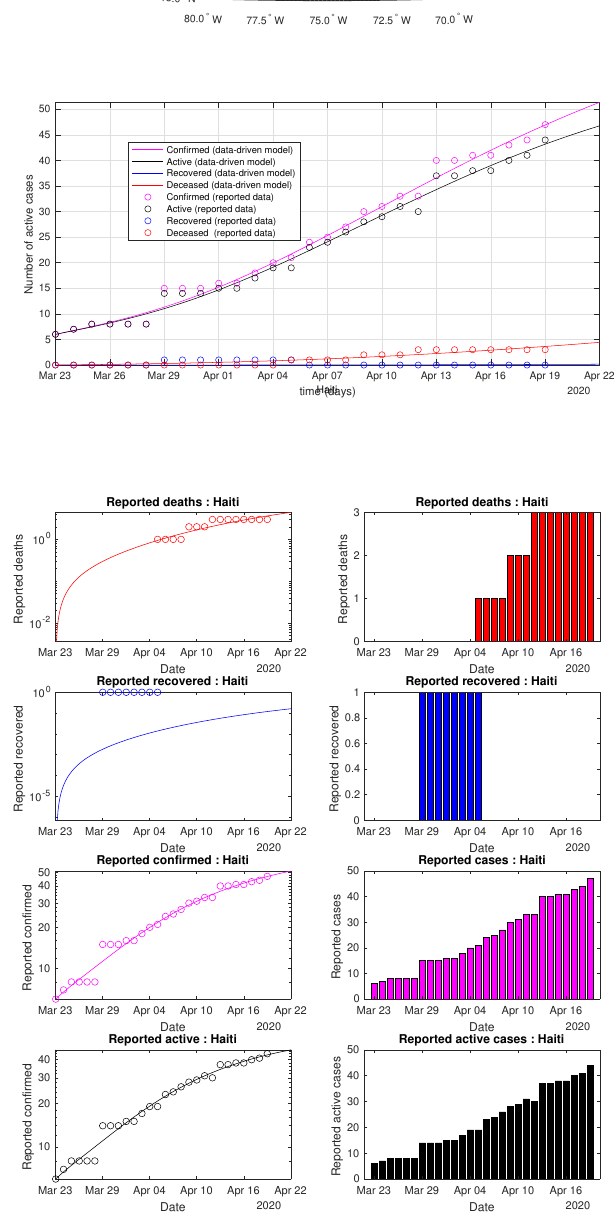
Figure 32. Haiti: data of active, recovered, deceased (in circle or bar) vs. model of active, recovered, deceased over time. Tracking the number of active cases. Predictive analytics for the next couple